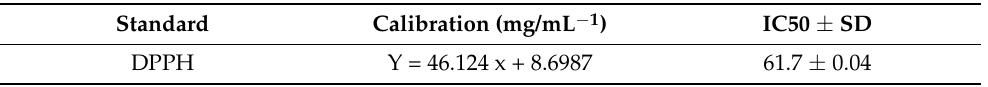
Table 6. Calibration data of antioxidant activity assay by DPPH and phenolic standard by Folin Ciocalteu reagent.